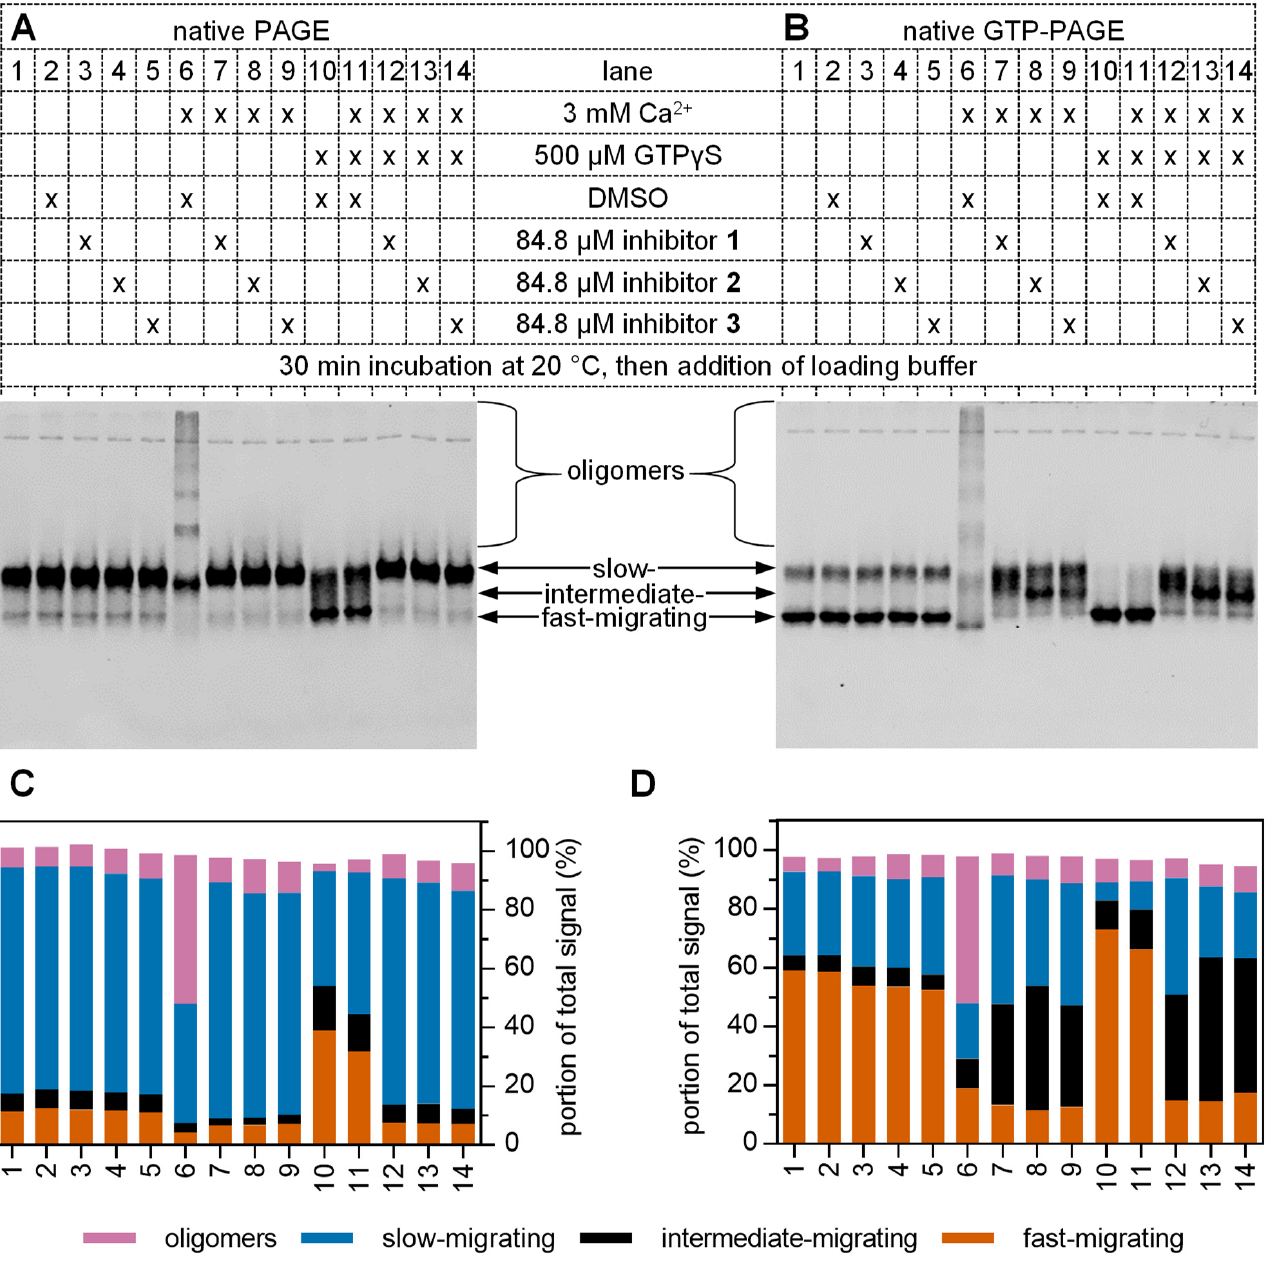
Figure 7. Influence of inhibitors 1 – 3 on the activity and conformation of hTGase 2 in the absence and presence of Ca 2+ or/and GTP γ S. Native (GTP-)PAGE was performed on 7% separating gels. The gel and the running buffer contained either no GTP ( A ) or 50 µM GTP ( B ). Samples of 8.23 µM self-produced hTGase 2 were incubated for 30 min at 20 °C in 100 mM MOPS pH 8.0, 100 mM NaCl, 5.33% ( v / v ) glycerol with CaCl 2 , DMSO or inhibitors 1 – 3 (2.12% DMSO), and GTP γ S as indicated. After adding native loading buffer, 6 µ L of each sample containing 3 µ g of hTGase 2 was loaded onto the gel. After the electrophoretic separation, gels were stained with Coomassie Brilliant Blue G250, scanned, and the protein bands were quantified (Figure S6 in Supplementary Materials). Four species of hTGase 2, i.e., oligomers and slow-, intermediate-, and fast-migrating species, were identified. ( C , D ) Percentage of the signals of the four species per lane in ( A , B ), respectively, are plotted as stacked bar charts.